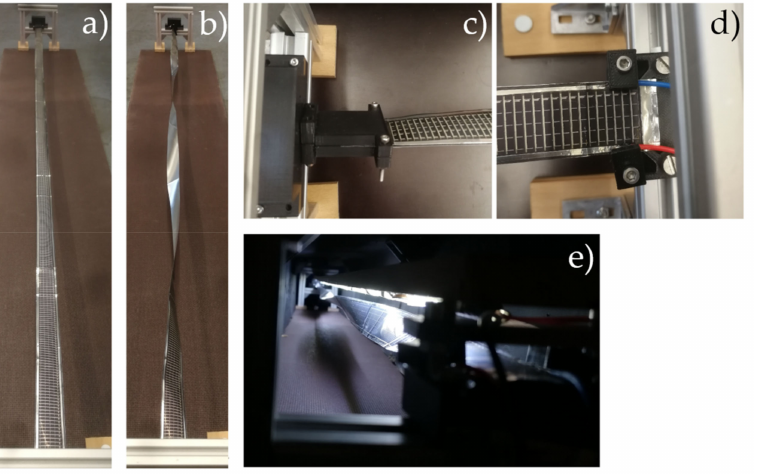
Figure 9. Twisting setup: ( a ) 1.5 m PTS without twisting; ( b ) 1.5 m PTS with 0.67 twists/m; ( c ) rotat- able mechanical fixing; ( d ) mechanical fixing with electrical connection; ( e ) full setup with twisted PTS placed under an LED strip inside a black box to avoid external light